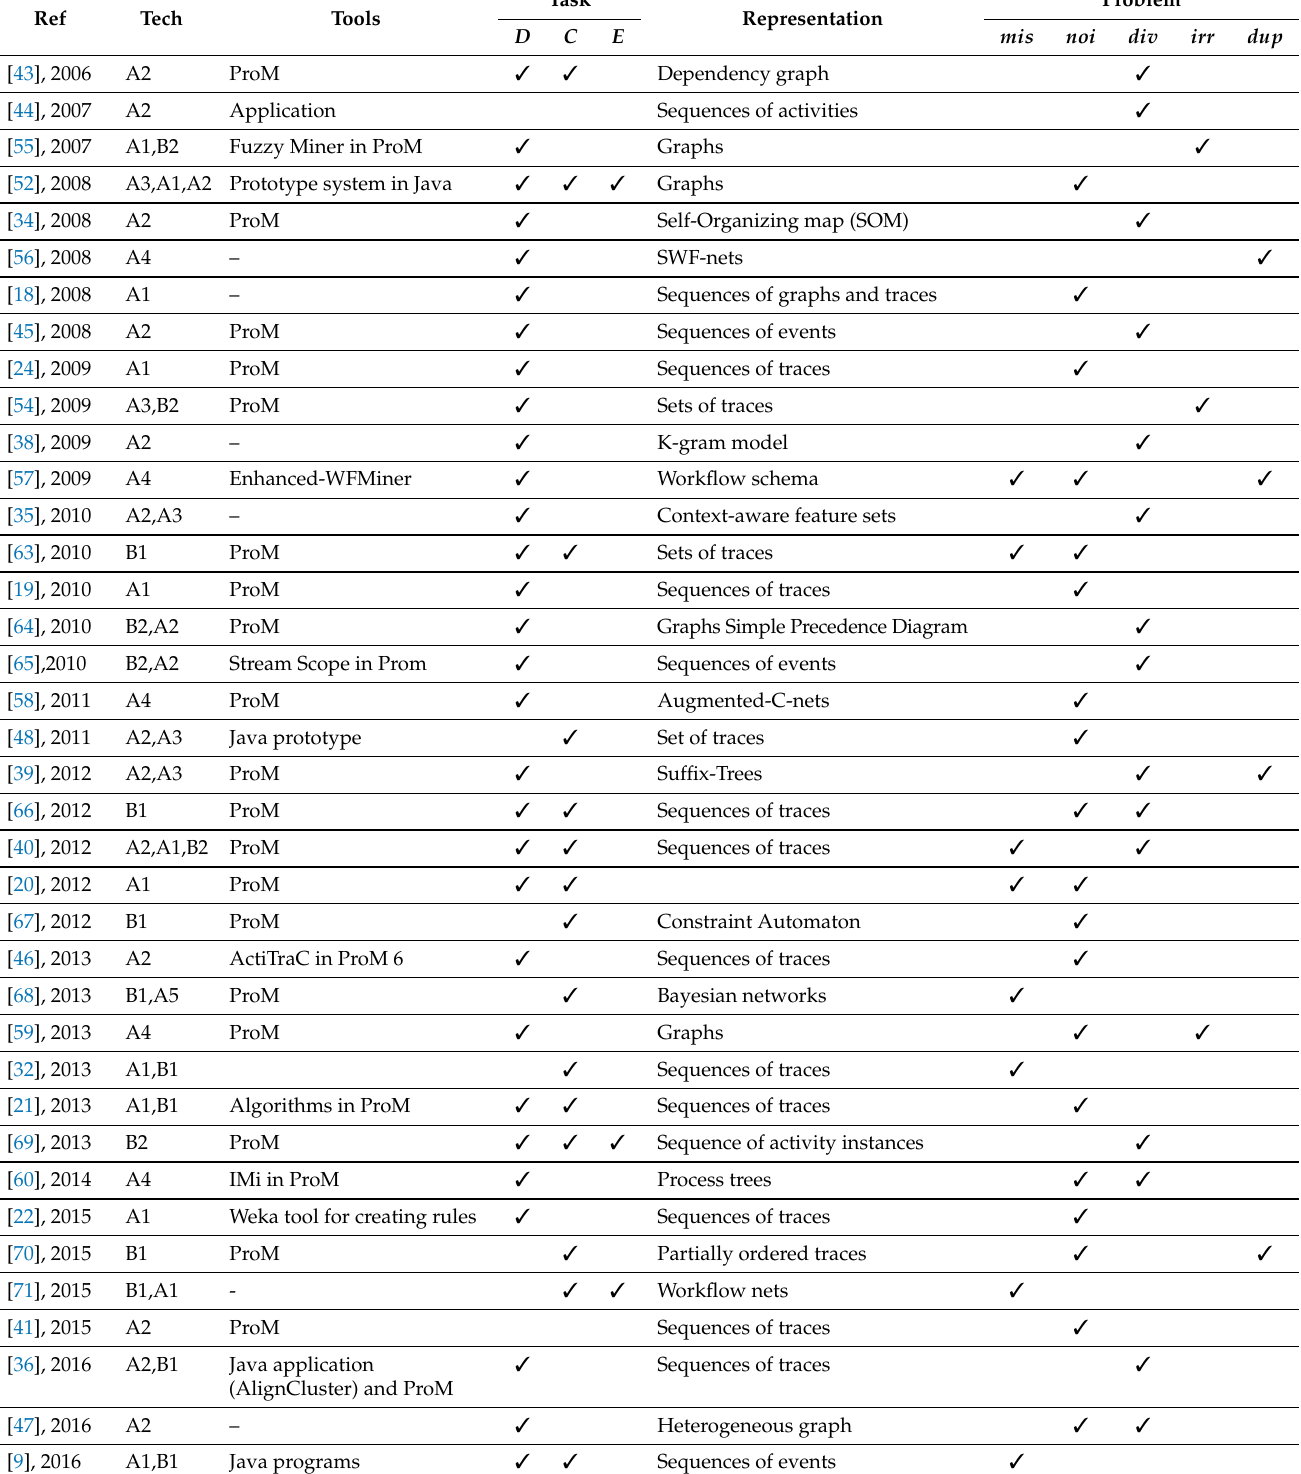
Table 4. Summary of the reviewed data preprocessing techniques in the context of process